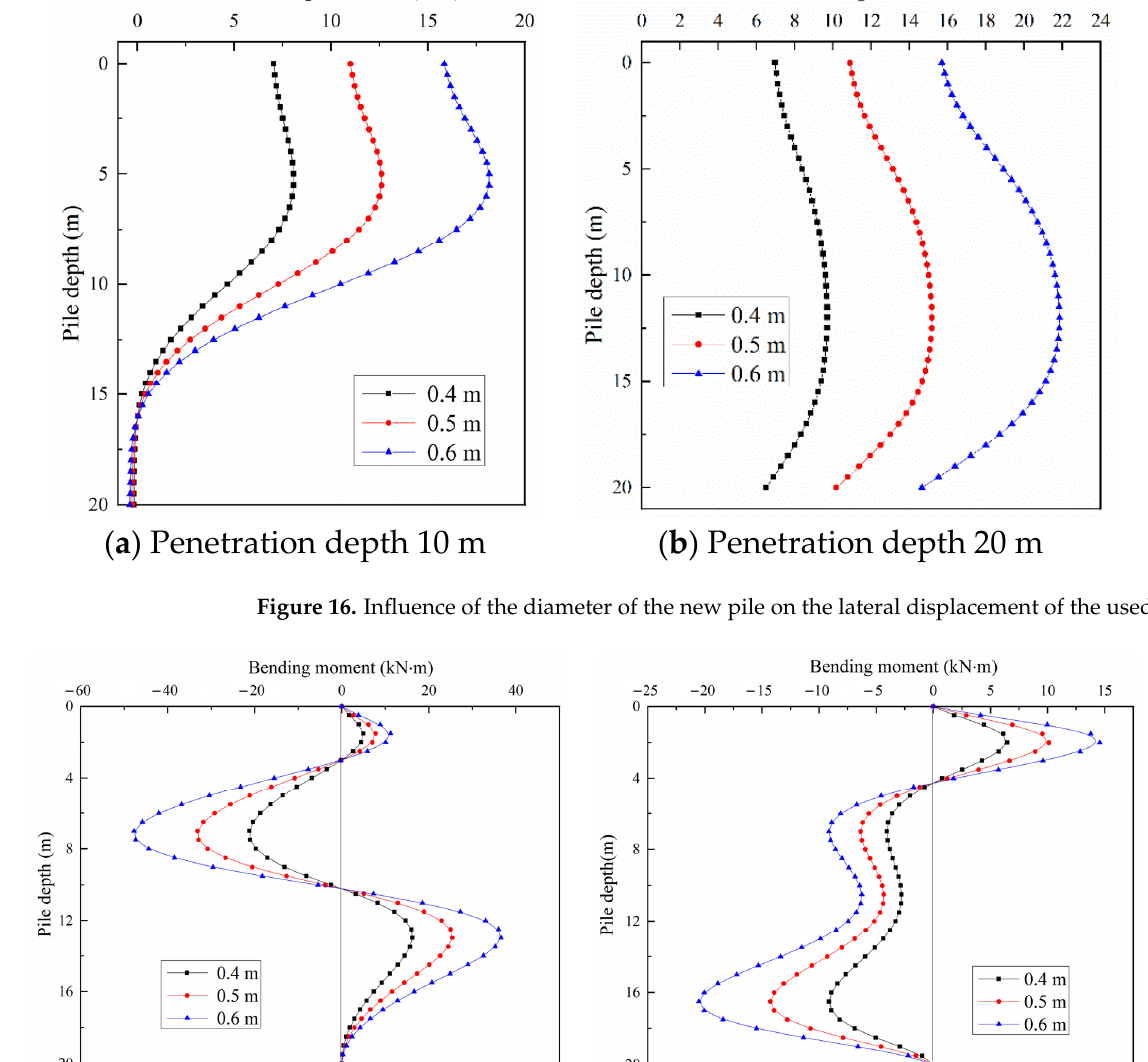
Table 2. Lateral displacement variation due to distance variation between the used and new piles.